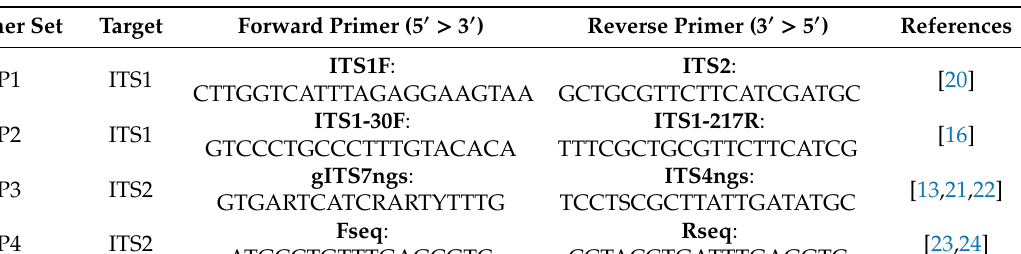
Table 2. List of selected primer sets used in this study. Primer sets P1 and P2 target the ITS1 region, while primer sets P3 and P4 target the ITS2 region.